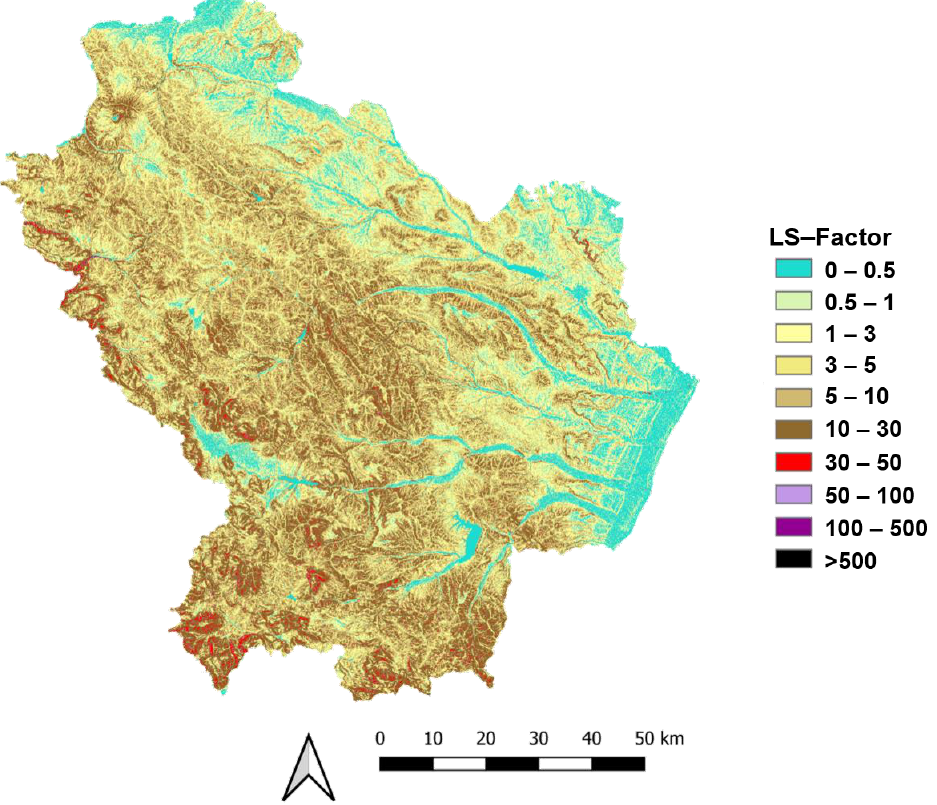
Figure 3. Slope length and steepness (LS)